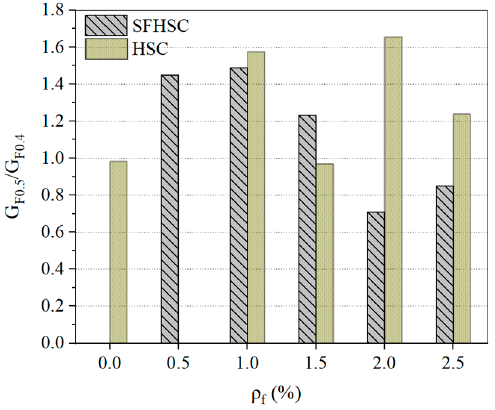
Figure 14. Influence of notch depth of beam on the fracture energy of SFHSC.